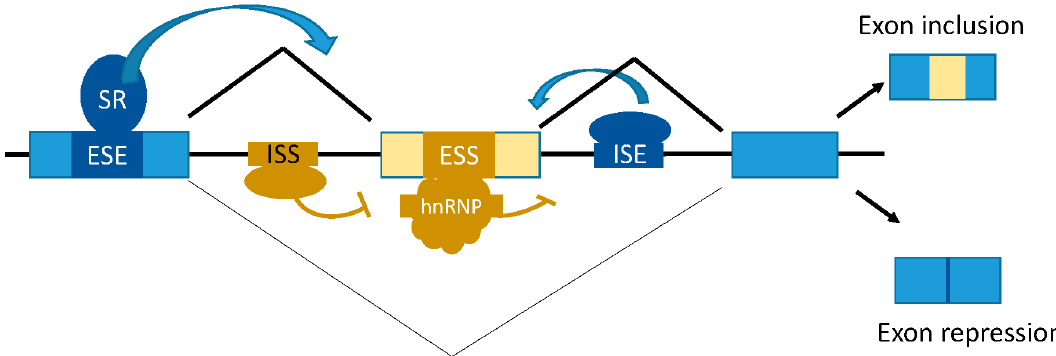
Figure 1. Mechanism of alternative splicing of pre-mRNAs. The cis- regulatory elements that control alternative splicing are composed of unique nucleotide sequences. The exonic splicing enhancers (ESE) and intronic splicing enhancers (ISE) (dark blue) respectively promote exon inclusion (light blue boxes), while exon repression requires the exonic splicing silencer (ESS) and intronic splicing silencer (ISS) elements (brown). The trans -acting factors that promote exon inclusion are the Serine (S)-Arginine (R) SR rich proteins while hnRNP proteins can promote exon skipping. In the diagram the middle exon can be included to give rise to a polypeptide with 3 exon units, while the alternatively spiced polypeptide skips the variable exon to yield a protein with 2 exon units.